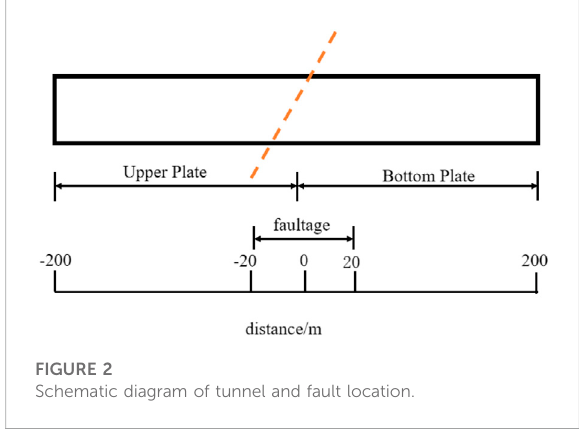
FIGURE 2 Schematic diagram of tunnel and fault location.